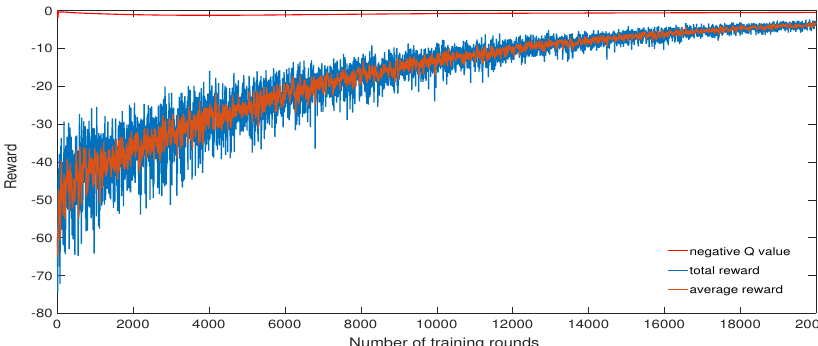
Figure 16. The change curve of the reward value after 20,000 rounds of training.